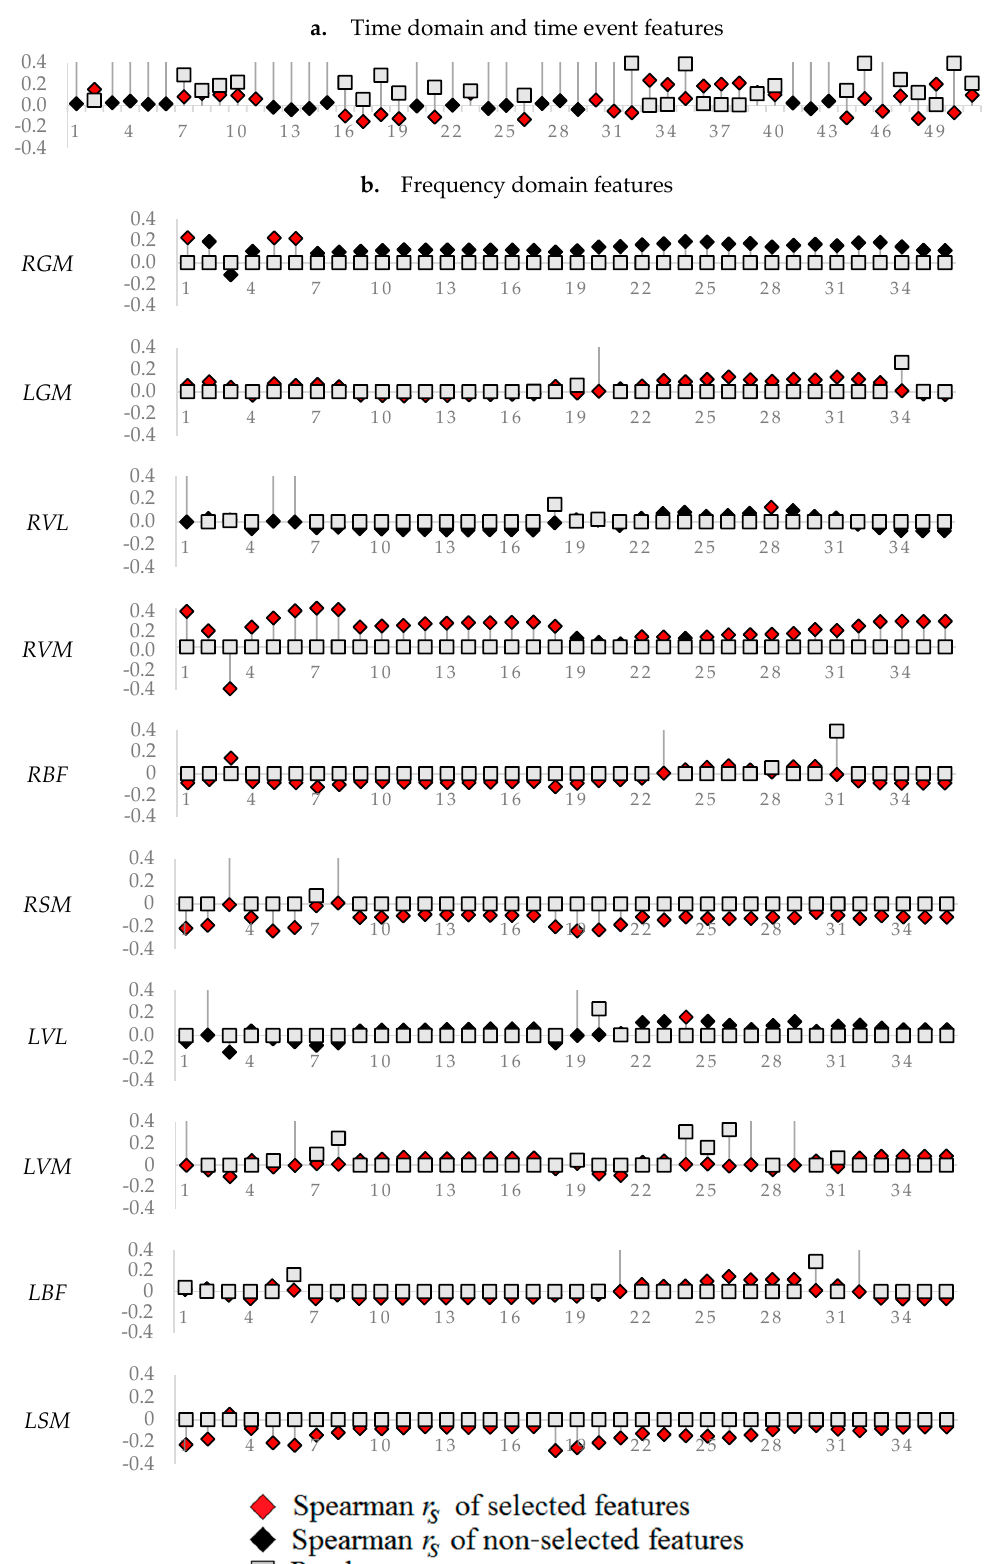
Figure 6. Spearman correlation between features and classes of running